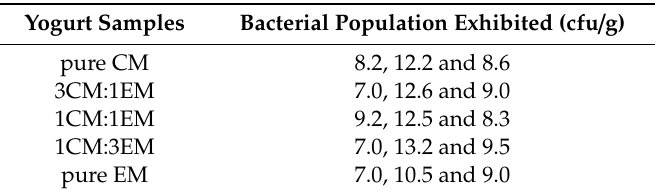
Table 5. Bacterial population detected in the di ff erent yogurt